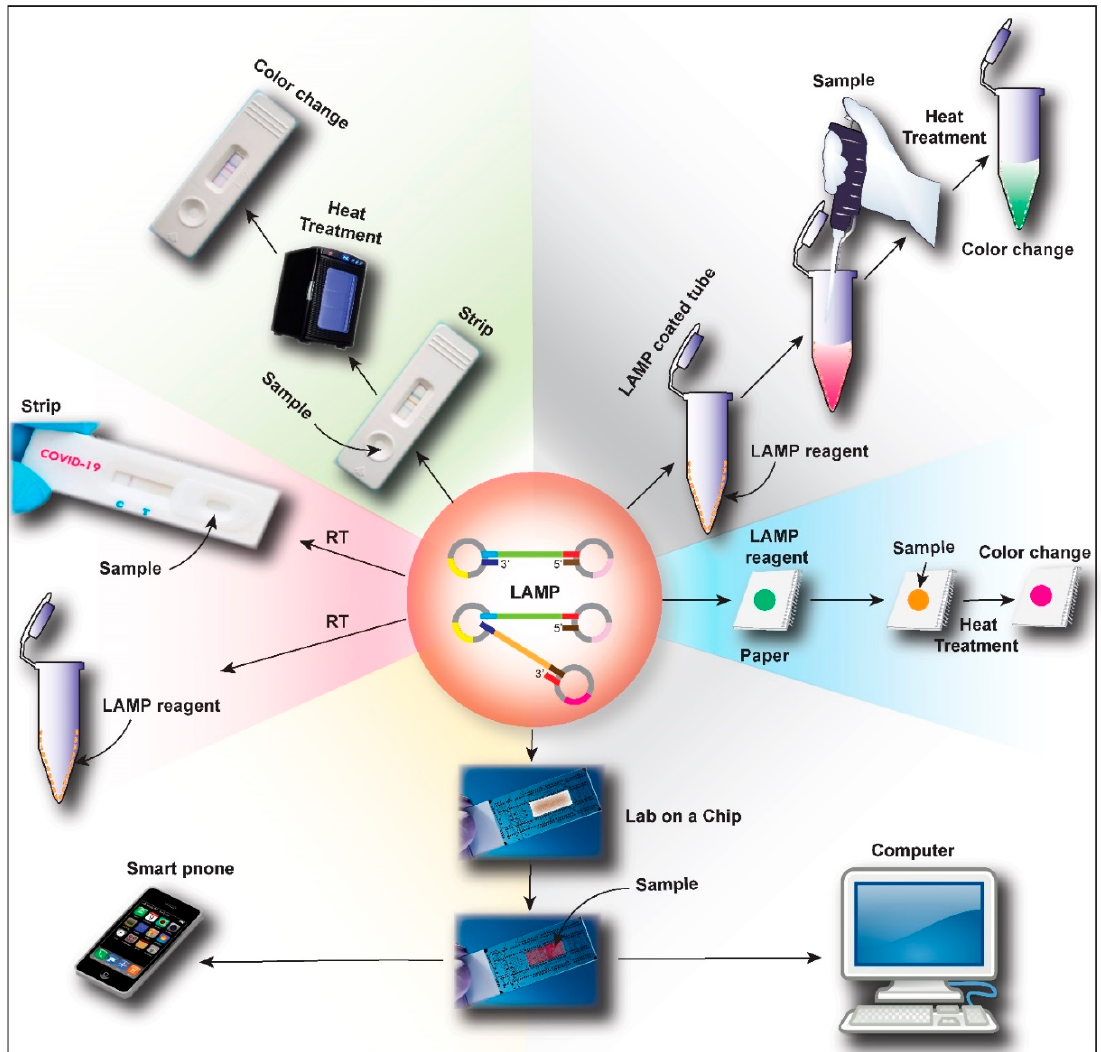
Figure 5. Schematic representation of the future possible advances in RT-LAMP based point-of-care test (PoCT) for novel coronavirus disease (COVID-19). LAMP reagents can be loaded in a paper-based system for easy use, which can be heated after sample loading to get quick results. Another advancement will be the coating of the LAMP reagent on the walls of a reaction tube where a simple mixing of the sample with the bu ff er and heating will give the results. Similarly, an RT-LAMP test-strip, like a conventional pregnancy detection kit, can also be developed. The researchers will also explore the possibility of developing an RT-LAMP master mix that can react at room temperature, which will fully transform the current concept of RT-LAMP based diagnosis. Most advanced development will be a lab on a chip (or LAMP on a chip) with advanced microfluidics, sensors, and computer integration, which can also be connected with an electronic device like computer or mobile phone to analyze the results.